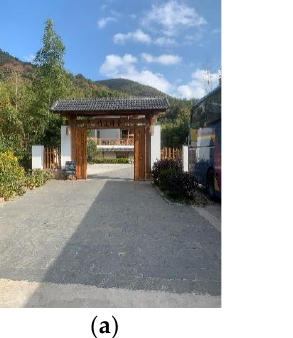
Figure 2. Photos of a site investigation of a typical home hotel: ( a ) exterior of the home hotel; ( b ) interior of the home